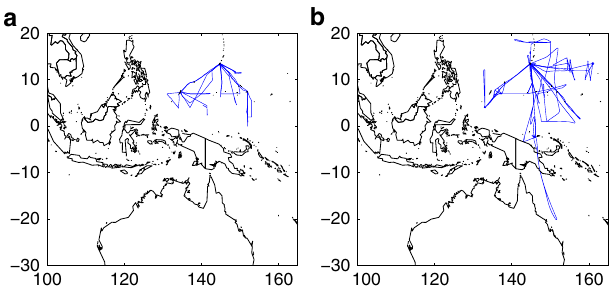
Figure 1 | Flight tracks for the CAST and CONTRAST campaigns. Tracks for ( a ) CAST and ( b ) CONTRAST flights analysed in this study.